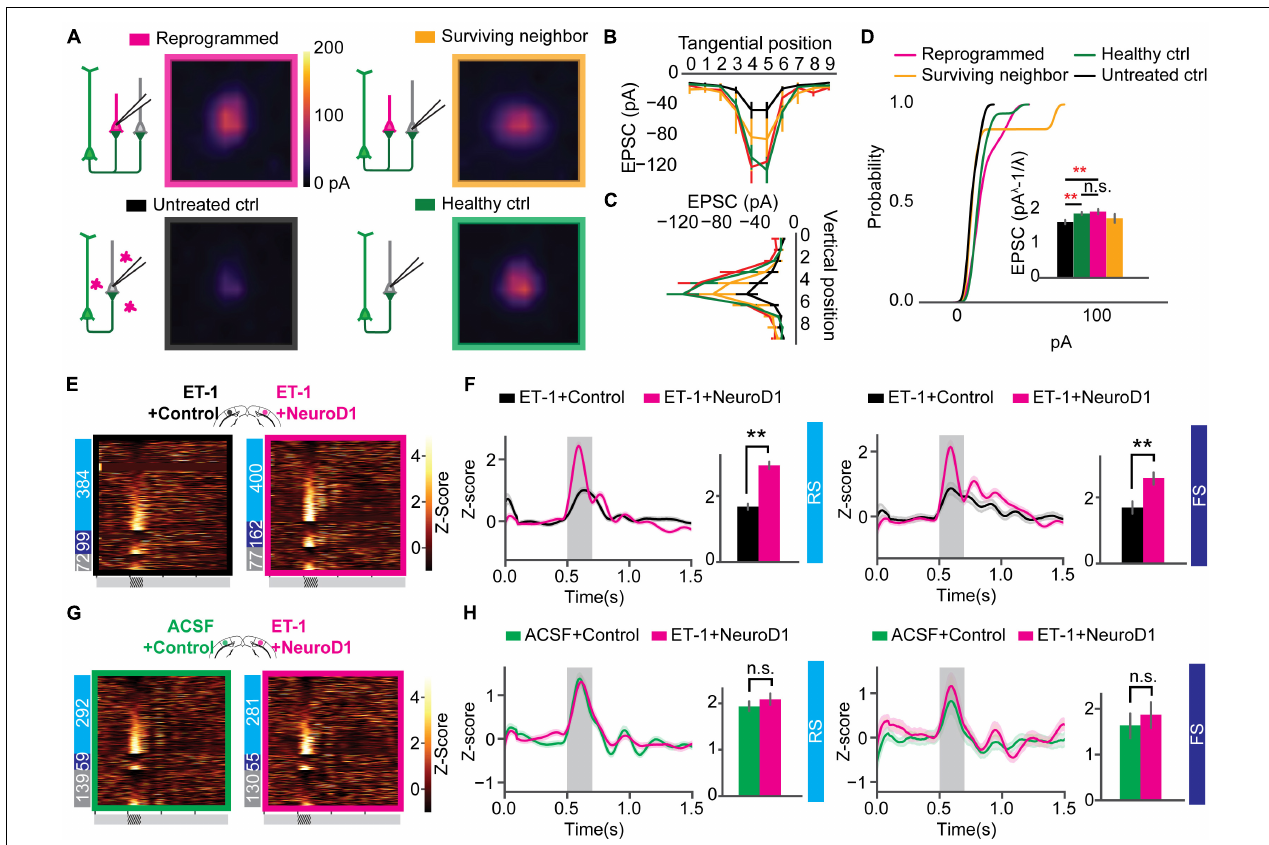
FIGURE 5 | Correction of circuit hyperconnectivity and fast-spiking unit responses at 6 weeks after in vivo direct reprogramming. (A) Averaged CRACM heat map of reprogrammed cells ( N = 12 cells from 9 mice), surrounding neighbors ( N = 8 cells from 9 mice), untreated control ( N = 16 cells from 6 mice), and healthy control ( N = 22 cells from 4 mice), measured at 6 weeks after viral infection. (B) Averaged maximal EPSC ± SEM by grid position in the tangential direction (parallel to the brain surface). (C) Averaged maximal EPSC ± SEM by grid position in the vertical direction (perpendicular to the brain surface). (D) The cumulative density curve showing the distribution of pooled EPSCs amplitude in panel (C) . The inset bar graph showing Box-Cox-transformed EPSCs amplitude comparison among groups. Reprogrammed vs. Untreated: p = 0.00995; Reprogrammed vs. Healthy: p = 0.900; Surviving vs. Healthy: p = 0.312. One-way ANOVA followed by Tukey post hoc tests. (E) Firing rate z-scores of all units in heatmaps for “ET-1+Control vs. ET-1+NeuroD1” group. The numbers of RS, FS, and UN units are shown on the left. (F) Firing rate z-scores of RS (left) and FS (right) units in the “ET-1+Control vs. ET-1+NeuroD1” group. RS units: N ET − 1 + Control = 384 units, N ET − 1 + NeuroD1 = 400 units, p = 4.09 × 10 − 3 . FS units: N ET − 1 + Control = 99 units, N ET − 1 + NeuroD1 = 162 units, p = 0.0065. 14 recordings. Mann-Whitney U -test with Bonferroni correction. (G) Same as (E) but for “ACSF+Control vs. ET-1+NeuroD1” group. (H) Same as (F) but for the “ACSF+Control vs. ET-1+NeuroD1” group. The shaded area represents visual stimulation. Peak z-scores within the visual stimulation window were quantified. RS units: N ACSF + Control = 292 units, N ET − 1 + NeuroD1 = 281 units, p = 0.499. FS units: N ACSF + Control = 59 units, N ET − 1 + NeuroD1 = 55 units, p = 0.540. 9 recordings. Mann-Whitney U -test with Bonferroni correction. ** p < 0.01 and n.s., not significant. Data are represented as mean ± SEM. See also Supplementary Figures 3, 4